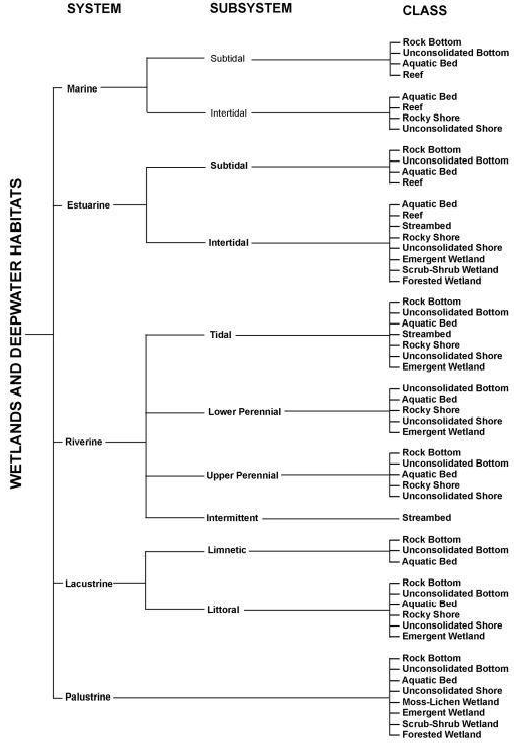
Figure 1. Cowardin Classification System (Corcoran et al., 2013) empirically observed that red band, near- infrared band, middle infrared band and derived Normalized difference Vegetation Index from optical satellite imagery, elevation, and curvature from topographic data, horizontal- vertical (HV) polarization of L-band Radar, and hydric soil data are key variables for differentiating between upland, water, and wetland classes. For classifying different wetland types, C-band radar and other spectral bands from satellite imagery are useful in addition to the other input variables. (Mahdianpari et al., 2020) also observed an increased accuracy trend when LiDAR, optical, and SAR data were combined for wetland